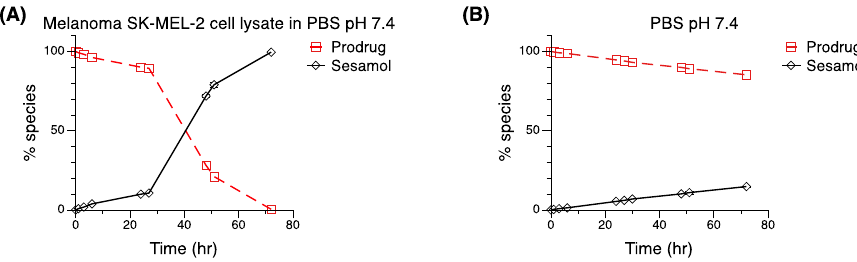
Figure 2. [ 14 C]-Leucine uptake inhibition testing of ( ◇ ) sesamol, ( ☐ ) sesamol prodrug, and (○) L - Figure 4. In vitro stability testing of sesamol prodrug (